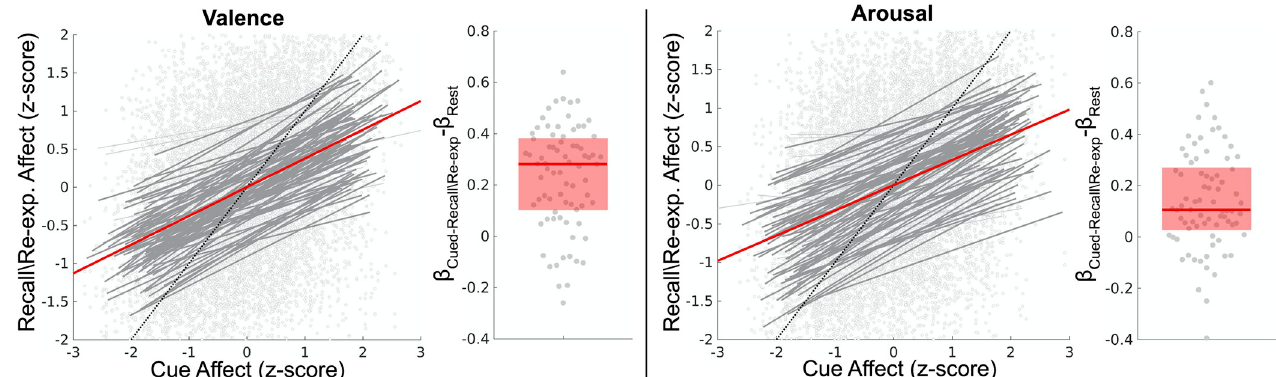
Fig 2. Estimation and validation of explicit affect regulation effects within the cued-recall/re-experiencing task. The figure depicts the effect size of cue affect processing in explaining the regulation of affect processing occurring during recall/re-experiencing (controlling for time lag in the 4 repeated measures of recall per each cue condition). Here affect processing measurements are standardized Platt-scaled neural decodings from our fitted SVM models. Valence and arousal dimensions of affect are decoded separately. The figure’s scatterplots depict the group-level effects computed using linear mixed-effects models which model random effects subject-wise. Bold red lines depict group-level fixed-effects of the cued affect. Bold gray lines depict significant subject-level effects whereas light gray lines depict subject-level effects that were not statistically significant. The figure’s boxplots depict the group-level difference between each subject’s explicit affect regulation measured during the cued-recall/re-experiencing task in comparison to non-explicit affect regulation constructed from the resting state task. The bold red line depicts the group median difference in effect size between cued-recall/re-experiencing and resting state. The red box depicts the 25–75th percentiles of effect size difference. Valence . The fixed effect (R 2 = .15) is significant (p < 0.001; t-test; h 0 : β = 0). Random effects significantly improve effect-size (p < 0.05; likelihood ratio test; h 0 : observed responses generated by fixed-effects only). Cued-recall/re-experiencing affect regulation effects are significantly greater than that of resting state effects (p < 0.001; Wilcoxon signed rank; h 0 : β Cued-Recall - β Rest = 0). The fixed-effect of control condition duration is significant ( β = .02; p = .035; t-test; h 0 : β = 0). Arousal. The fixed effect (R 2 = .11) is significant (p < 0.001, t-test; h 0 : β = 0). Random effects significantly improve effect-size (p < 0.05; likelihood ratio test; h 0 : observed responses generated by fixed-effects only). Cued-recall/re-experiencing affect regulation effects are significantly greater than that of resting state effects (p < 0.001; Wilcoxon signed rank; h 0 : β Cued-Recall - β Rest = 0). The fixed-effect of control condition duration is not significant ( β = .01; p = .26; t-test; h 0 : β =